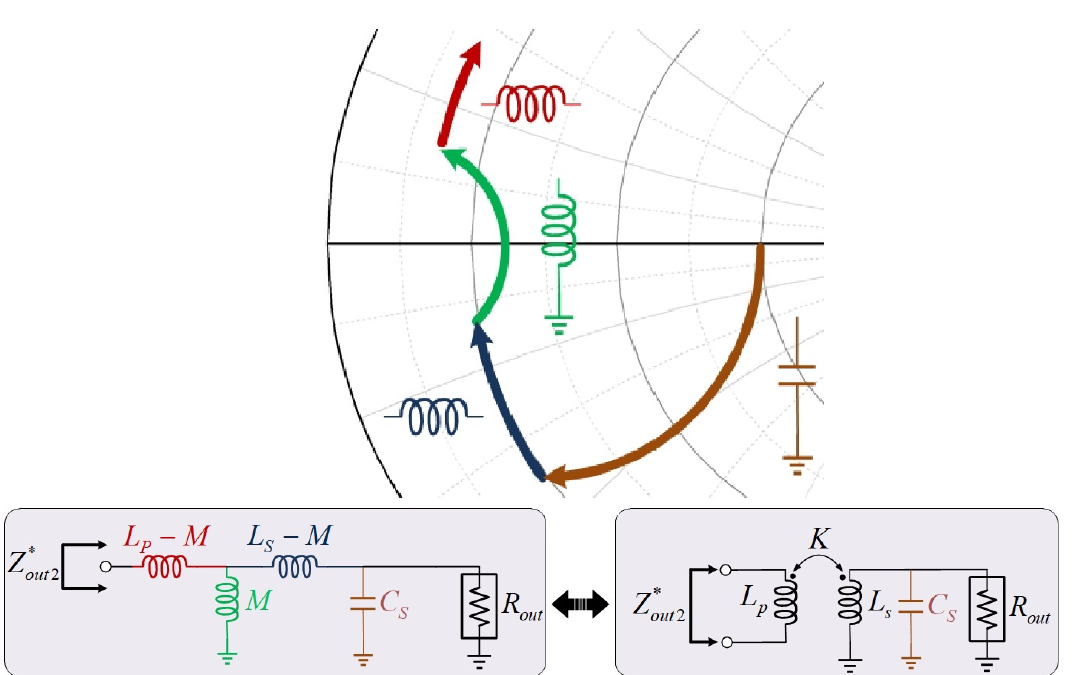
Figure 9. Smith chart of the output matching network with transformer T-model and its equivalent transformer.